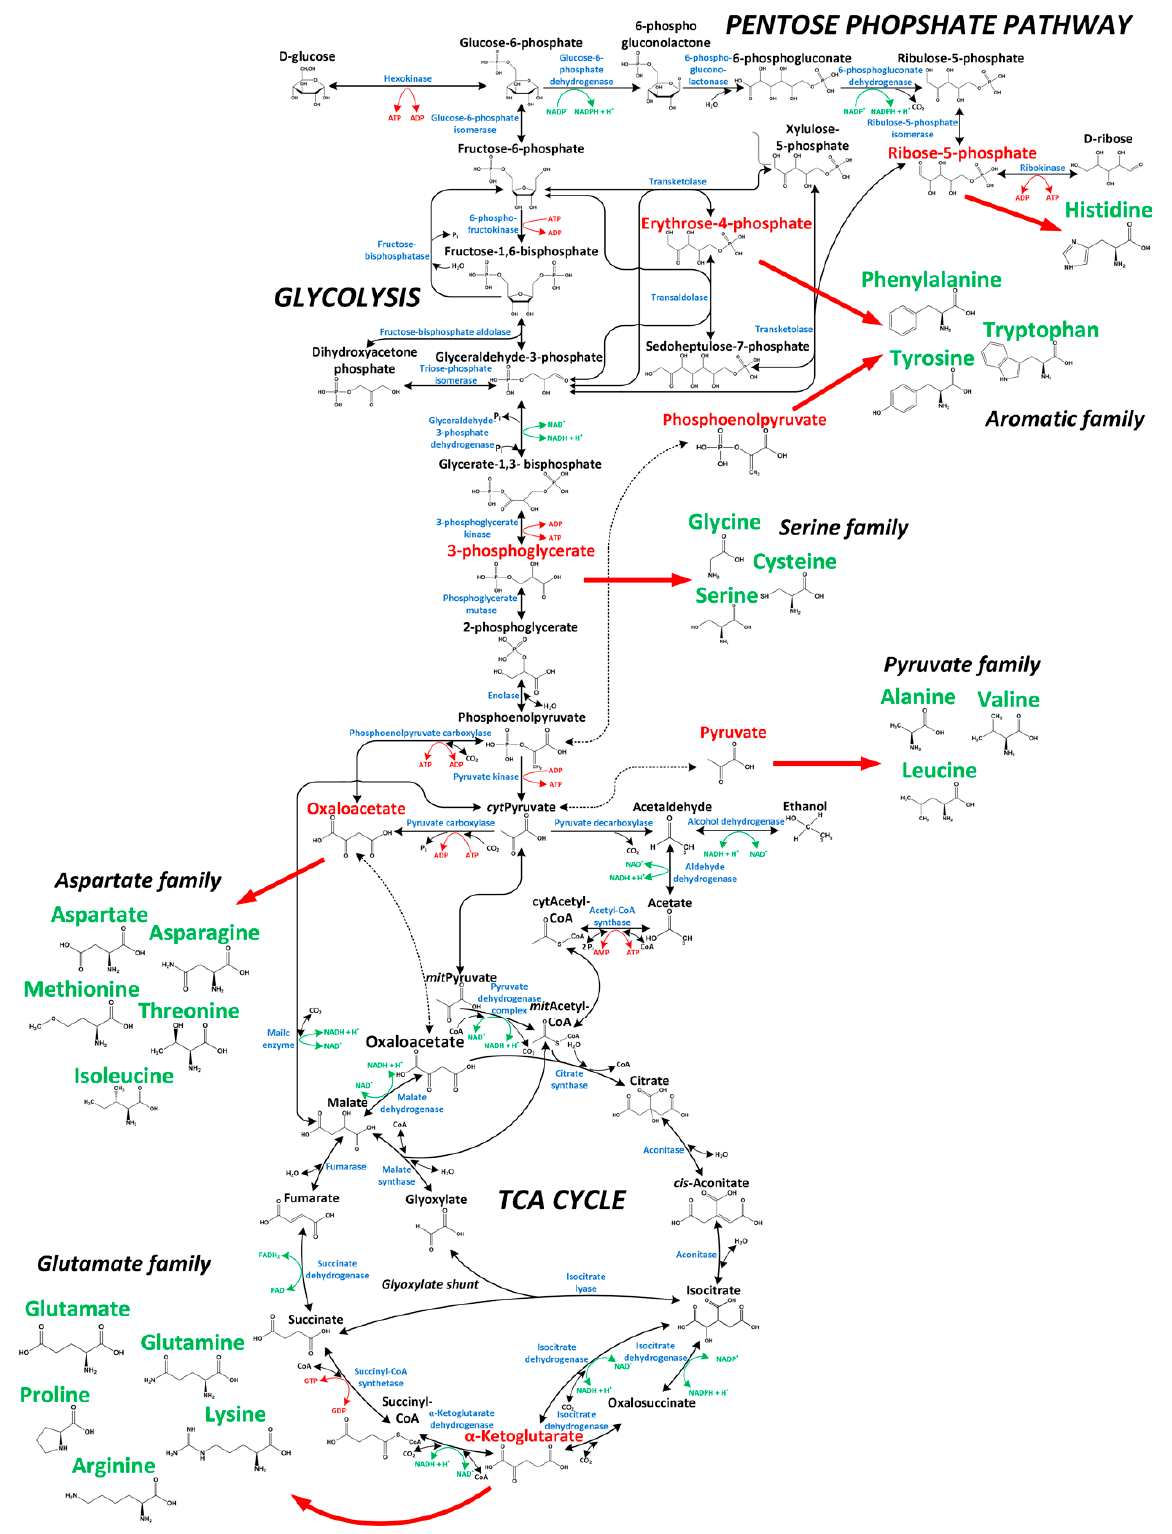
Figure 1. Central carbon metabolism of H. polymorpha RB11 conphys with precursor metabolites (red) for the biosynthesis of the 20 proteinogenic amino acids (green).